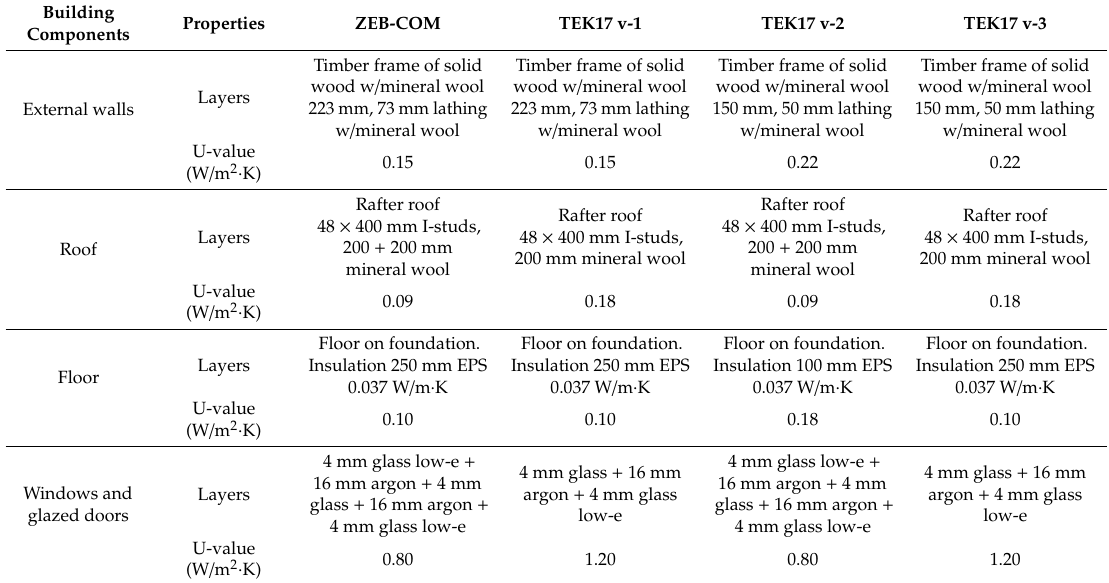
Table 5. Description of layers and U-value of the building components of the base case and